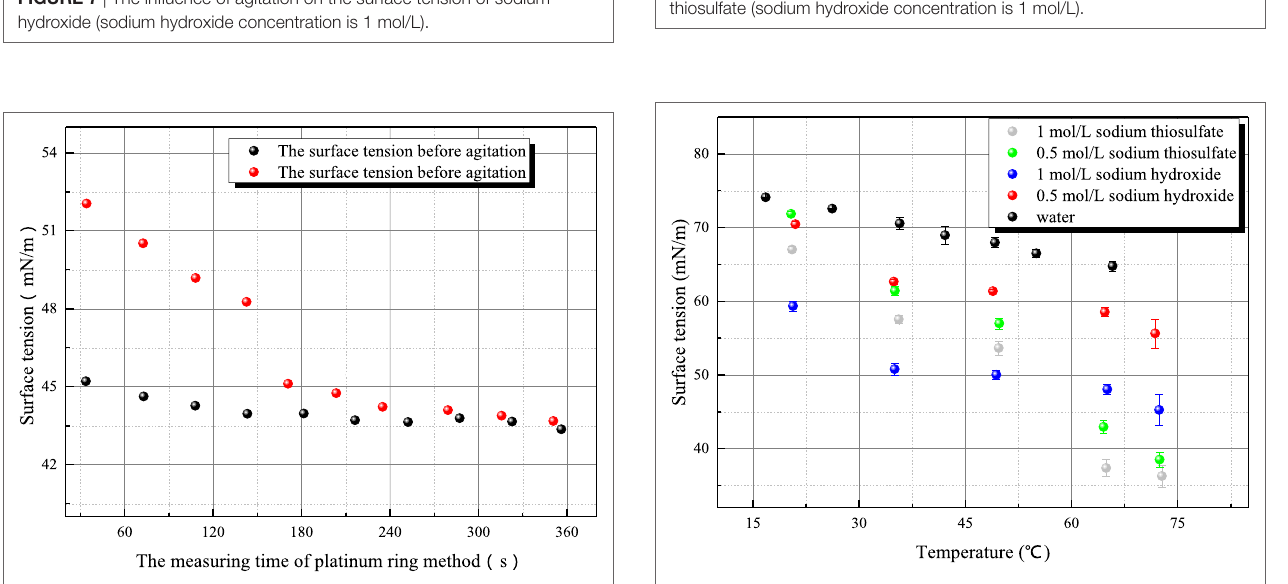
FigUre 10 | The relationship of the surface tension of aqueous inorganic and